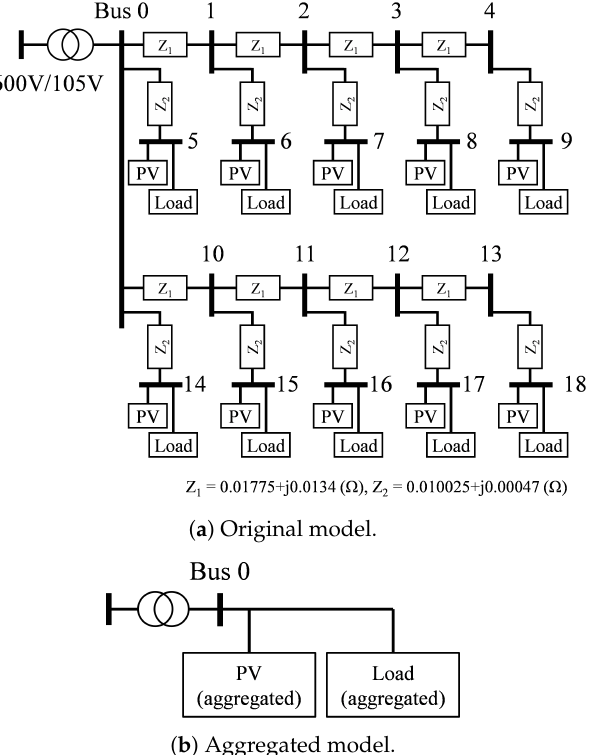
Figure 3. Simulation models of a Japanese LVDS. ( a ) The original model with 19 buses, including 10 PV and load buses, are ( b ) aggregated into one bus. Volt-var control is implemented in all PV